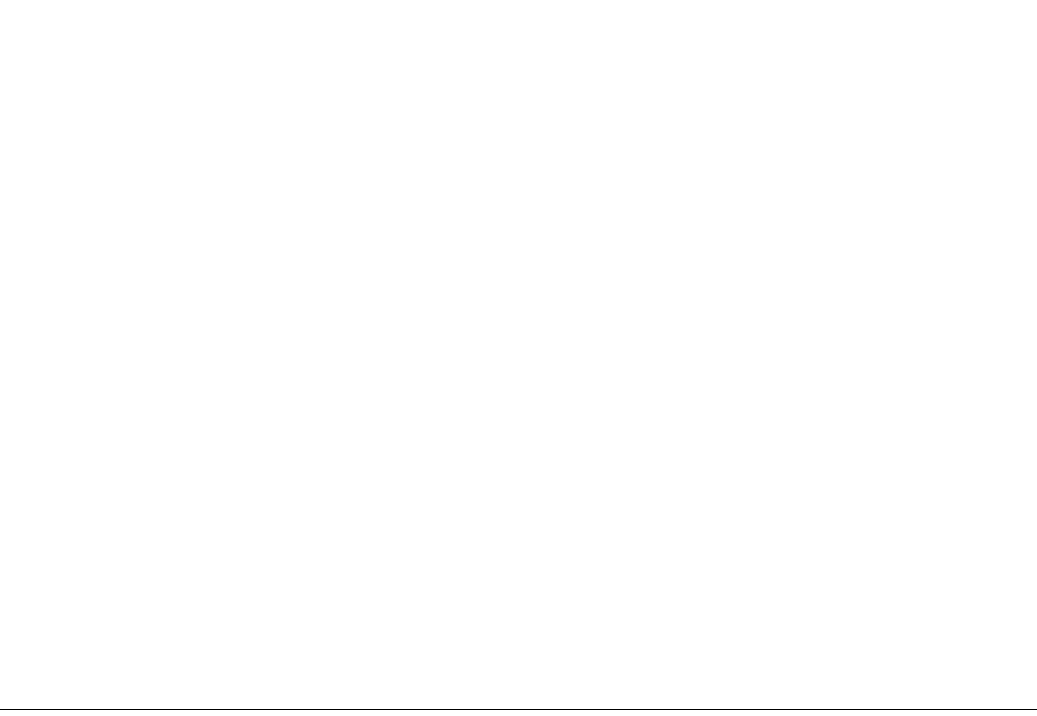
FIGUREA4 | Spatial maps of components in module IV for HCs (upper) and SZs (lower). Hubs of this module in each group are labeled. Each column shows one component in axial, sagital, and coronal views. There are three common components (in the box) including two parietal components and one frontal component. HCs have another eight components including two frontal components, two occipital components, one temporal component, one central component, one